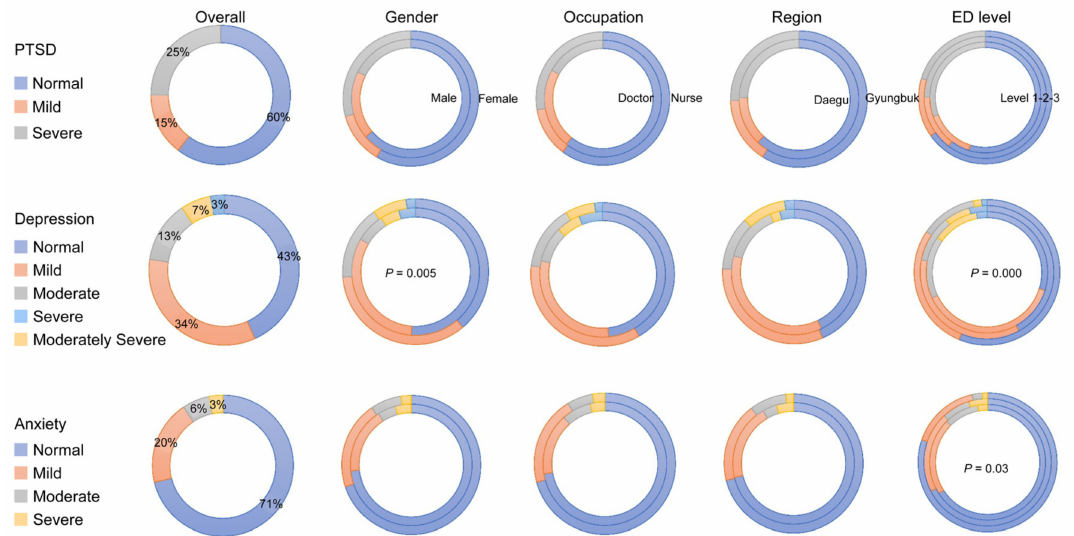
Figure 1. PTSD, depression and anxiety status of respondents. Values are presented as percentage (%). PTSD, post-traumatic stress disorder; ED, emergency department. PTSD: Korean version of the Primary Care Post-traumatic Stress Disorder Screen for the Diagnostic and Statistical Manual-5 (PC-PTSD-5), 0–1 = normal, 2= mild, 3–5 = severe. Depression: The Korean version of the Patient Health Questionnaire-9 (PHQ-9), 0–4 = normal, 5–9 = mild, 10–14 = moderate, 15–19 = moderately severe, 20–27 = severe. Anxiety: By the Korean version of generalized anxiety disorder-7 (GAD-7) scale, 0–4 = normal, 5–9 = mild, 10–14 = moderate, 15–21 =